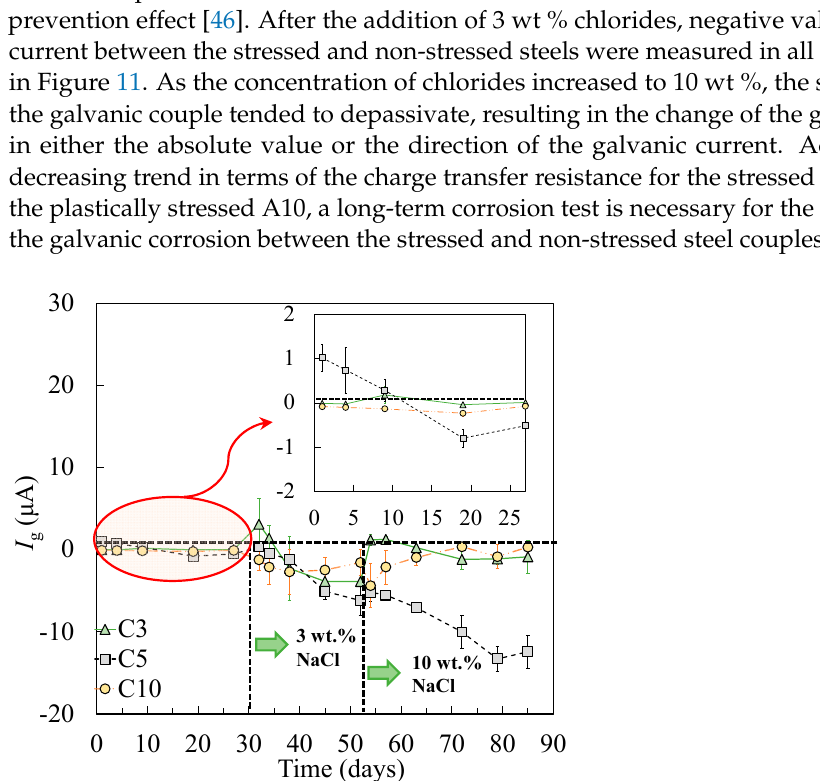
Figure 10. Resistances of individual and coupled steel specimens subjected to 33% of σ y ( a ), 55% of σ y ( b ), and 110% of σ y ( c ).